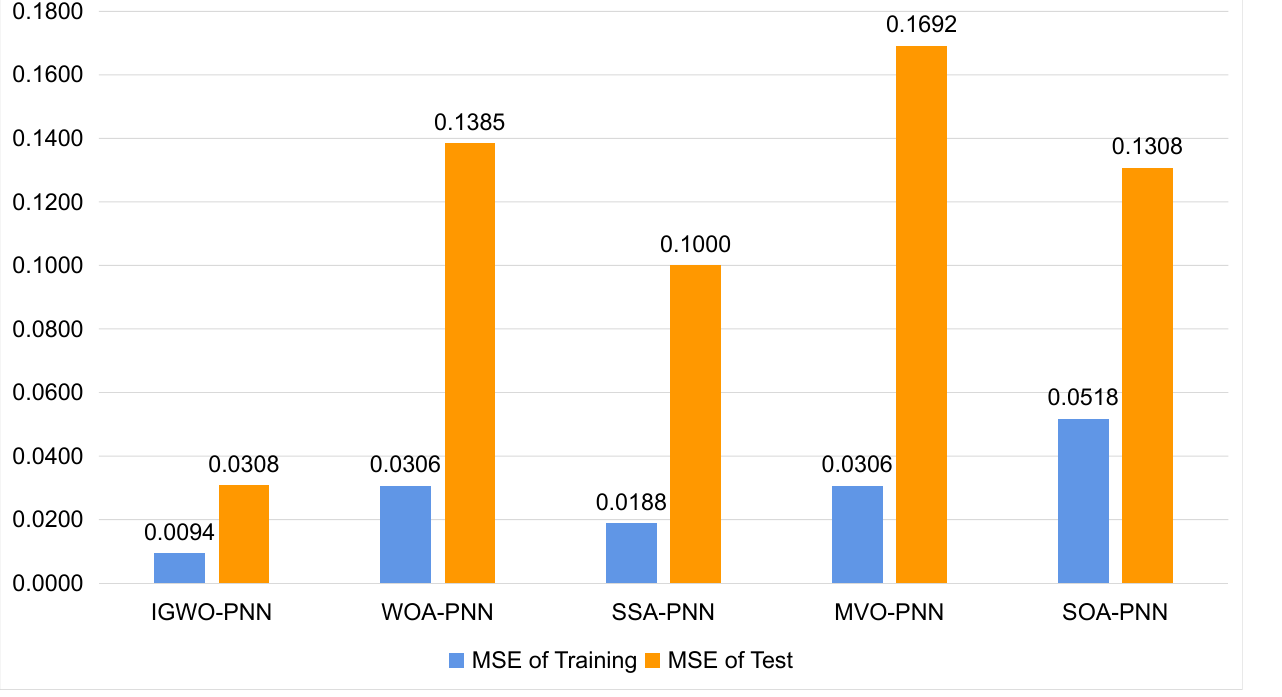
Figure 9. Comparison of the MSE of the second set of comparison